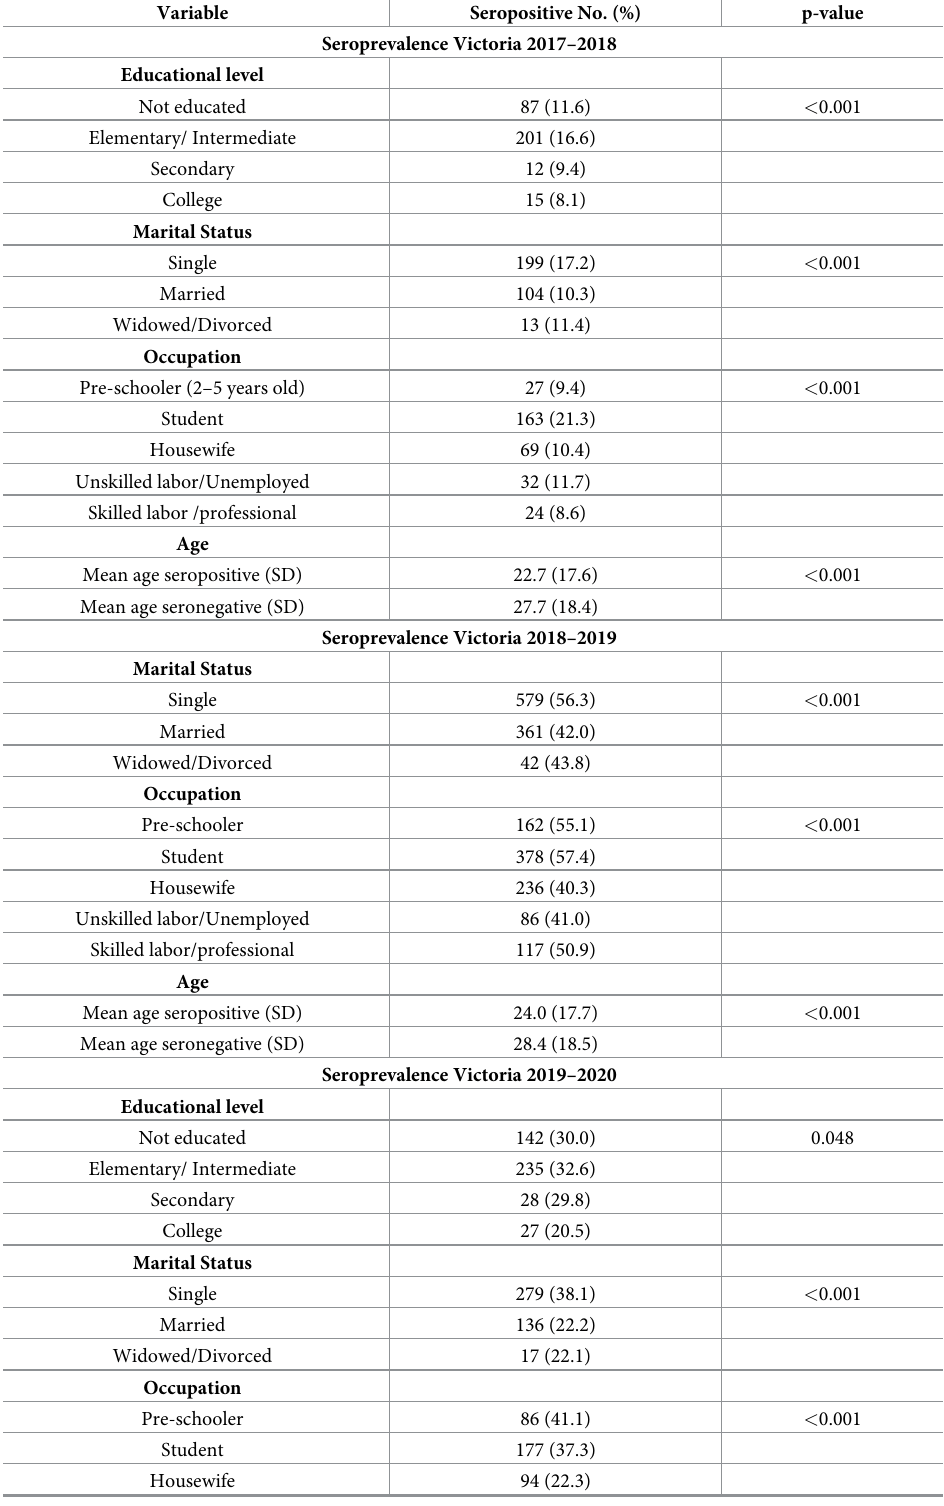
Table 4. Determinants of seroprevalence among study participants, 2017–2019 in